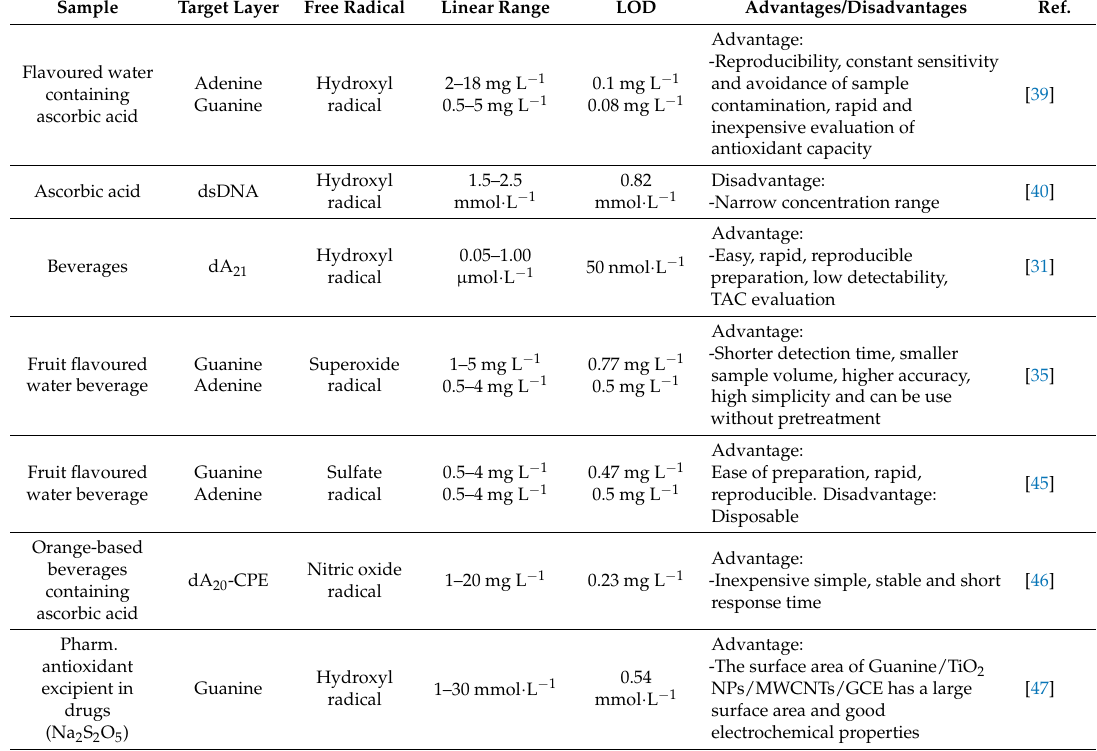
Figure 3. Electrochemical sensing of oxidative DNA damage and its restoration by antioxidants (immobilization method on the working electrode was adsorption on GCE). Table 2. Comparison of performances of DNA electrochemical sensors for total antioxidant capacity.